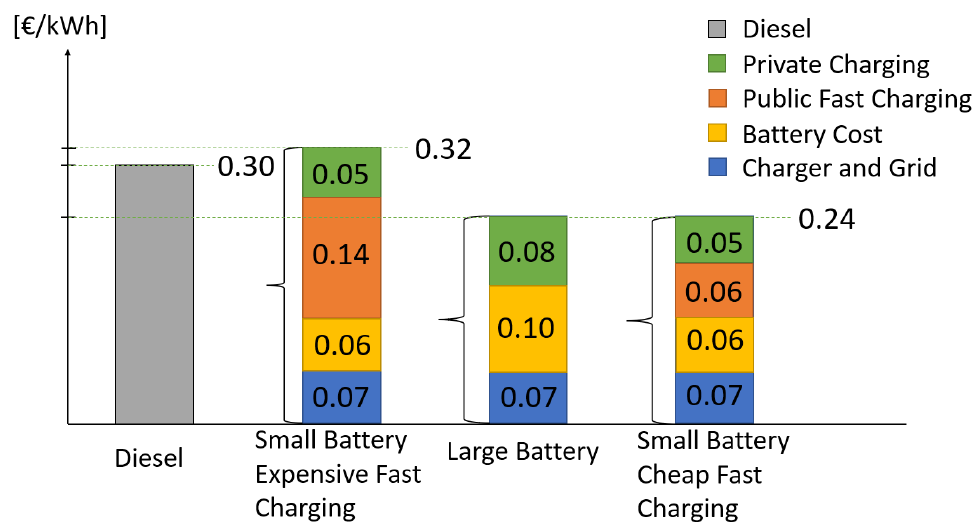
Figure 8. Cost of alternative strategies for the studied haulage company, in EUR/kWh. (The individual costs of the battery electric truck with a large battery seem to add up to more than the total cost, but this is due to